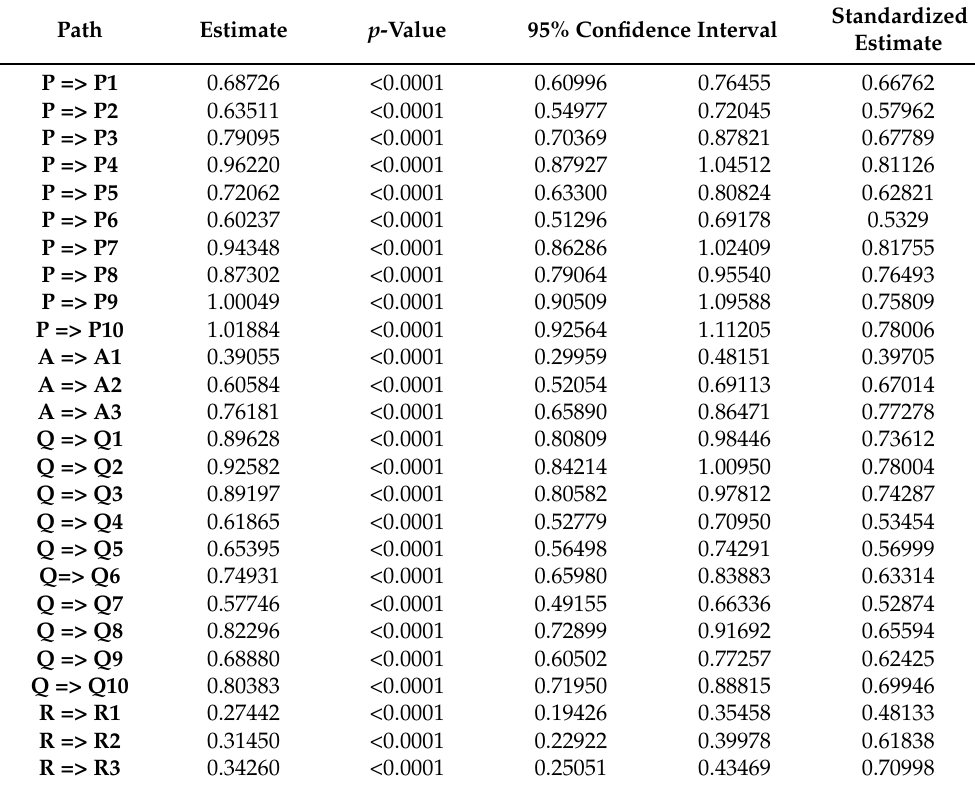
Table 4. Estimates of the ERT measurement constructs.